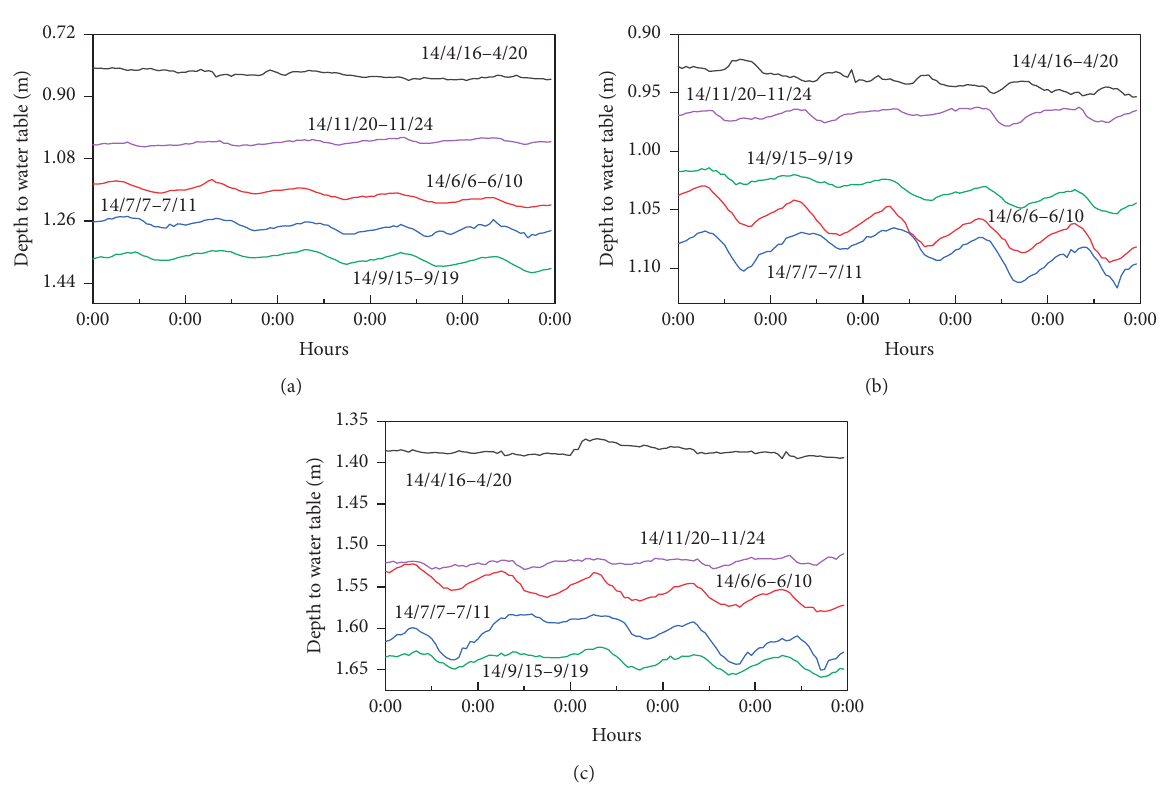
Diurnal fluctuation was detected